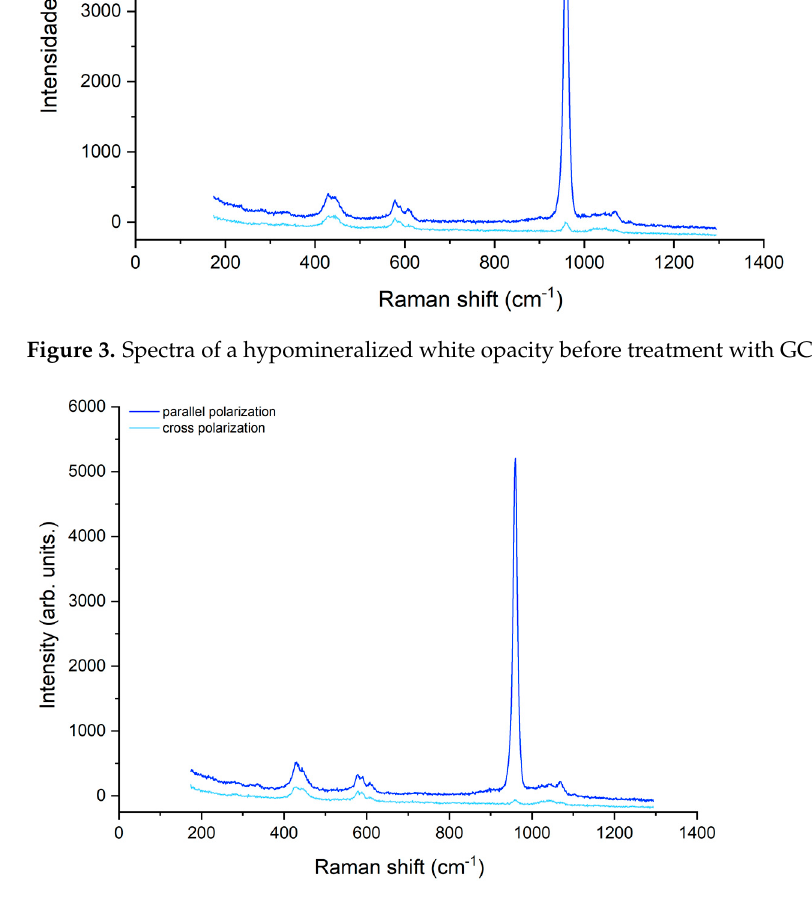
Table 1. Mean depolarization ratio and standard deviations (SD) of the symmetric stretching band of phosphate values for the three